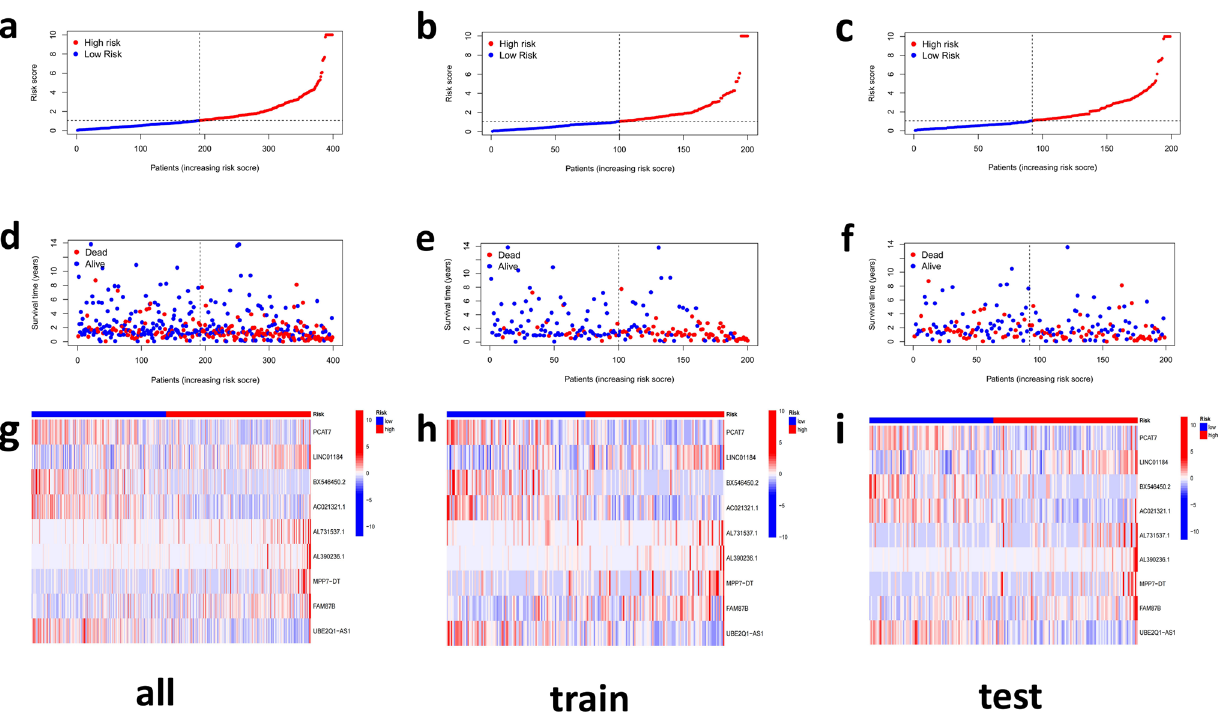
Fig. 5 Distribution of BCa patients based on the risk score a – f Risk curve and scatter plot for the risk score and survival status of each BCa group sample. g – i Heat map showing the expression profiles of Cuprotosis-related nine-LncRNA in the all, train, test group samples